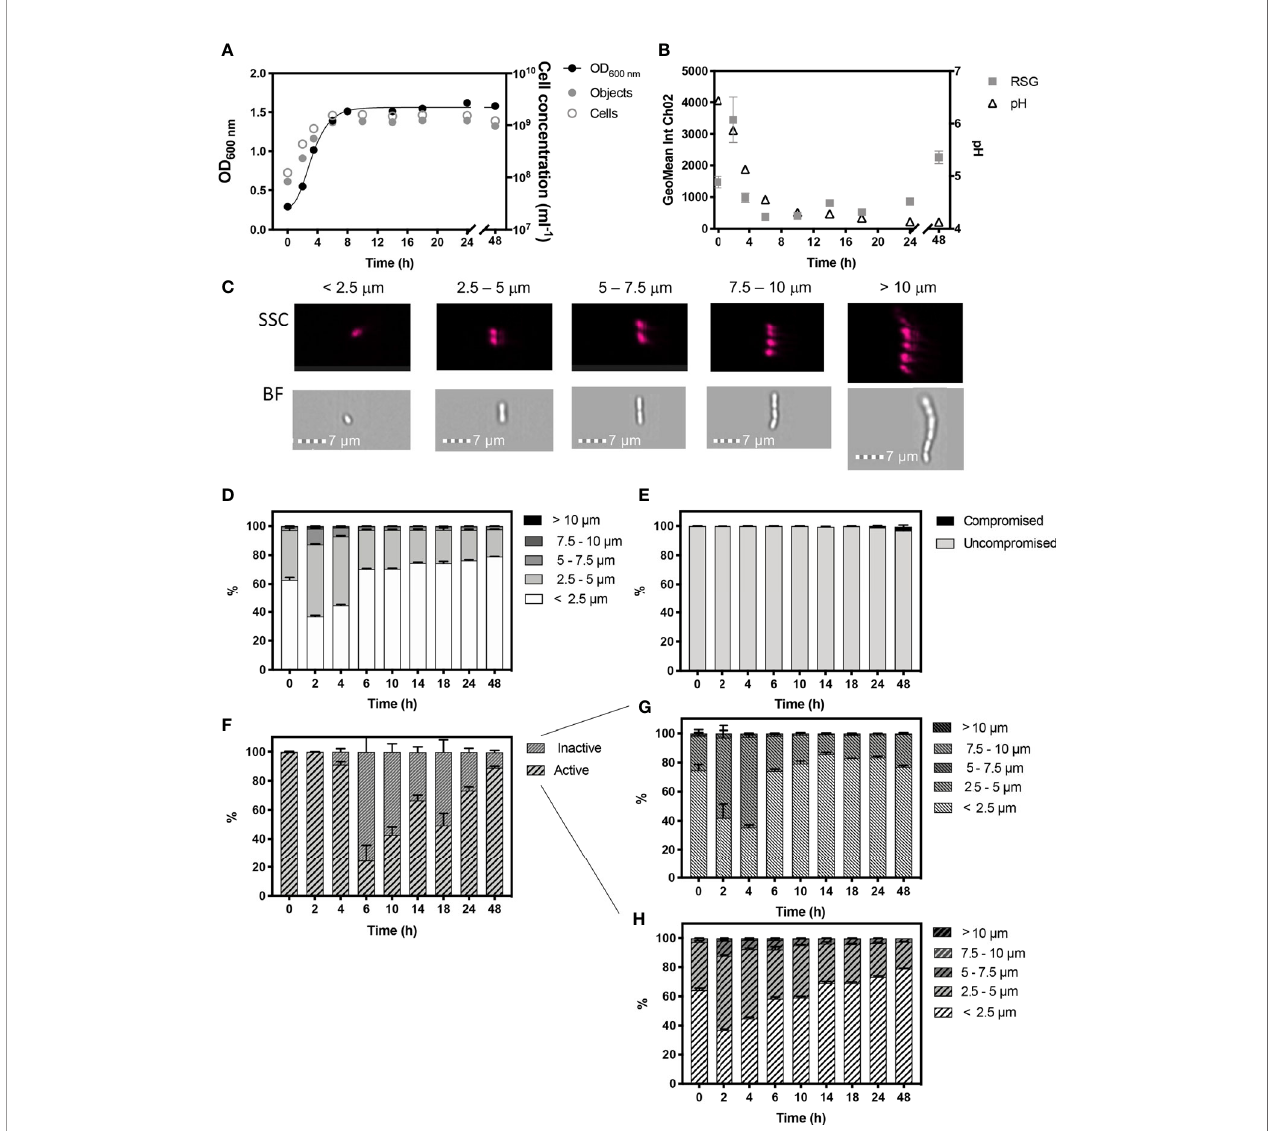
FIGURE 2 | Monitored phenotypes of Lactiplantibacillus plantarum WCFS1 during 48 h growth. Measurements of Optical density (OD 600 ) are plotted against IFC determined cell concentrations displayed as objects (ml -1 ) and cells (ml -1 ) (A) . Cells ml -1 was calculated via normalization of object concentration by cell size and used as a proxy for biomass. The geometric mean of redox sensor green (RSG), indicative of metabolism, was determined from Channel 2 (Ch02: 533/55 nm) intensity and is plotted alongside media pH (B) . Cell phenotypes were characterised by cell length, determined by bright fi eld (BF) and side scatter (SSC) properties (C) . Proportions of cell length during growth are shown (D) . The proportion of cells with compromised and uncompromised cell membranes, was tracked using propidium iodine and determined by red fl uorescence intensity (Ch05: 702/85 nm), normalised for cell area (E) . Proportions of metabolically ‘ active ’ and ‘ inactive ’ cells are presented (F) and cell lengths of ‘ inactive ’ (G) and ‘ active ’ (H) cells within the uncompromised population are shown . n =5 ; error bars represent standard error of the